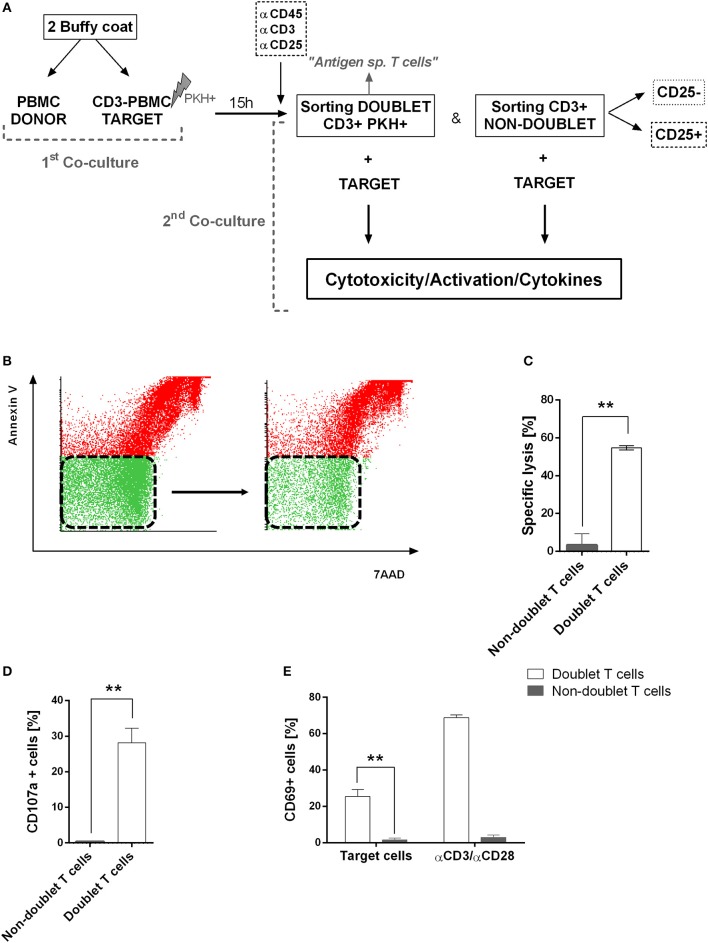
Functional assays of doublet-forming T cells. (A) Schedule of the procedure: PBMC from donor were co-cultured with target PBMC depleted of CD3 cells, irradiated and stained with PKH-67 (first co-culture). After 15 h, cells were stained with CD3, CD45, and CD25 monoclonal antibodies for cell sorting. Doublet positive T cells (CD3+PKH+) and non-doublet T cells (CD3+PKH–) were sorted and rested for 20 h. Target cells were thawed and stained with PKH-67 and secondary co-cultures between doublet-forming T cells or non-doublet T cells with target cells were performed (second co-culture). After 7 h, cells were collected and stained with 7AAD and Annexin V. (B) Dot plots show 7AAD and Annexin V staining of target cells alone (left) or co-cultured with doublet T cells (right) in one case as an example of analyses performed. (C) The bar diagram shows the specific lysis of doublet-forming T cells vs. non-doublet T cells. The specific lysis was calculated following the next formula: [(target viability alone–target viability with doublet or non-doublet T cells)/ target viability alone] × 100. Data show mean values ± SD of six independent experiments. (D) The bar diagram shows the expression of CD107a cytotoxic marker of doublet-forming T cells vs. non-doublet T cells. Data show mean values ± SD of three independent experiments. (E) The bar diagram shows the percentage of T cell activation marker CD69 on secondary co-cultures after 24 h of incubation as determined by flow cytometry. Data show mean values ± SD of three independent experiments. P-values between the indicated groups were calculated using paired Student t-tests. **p < 0.01.